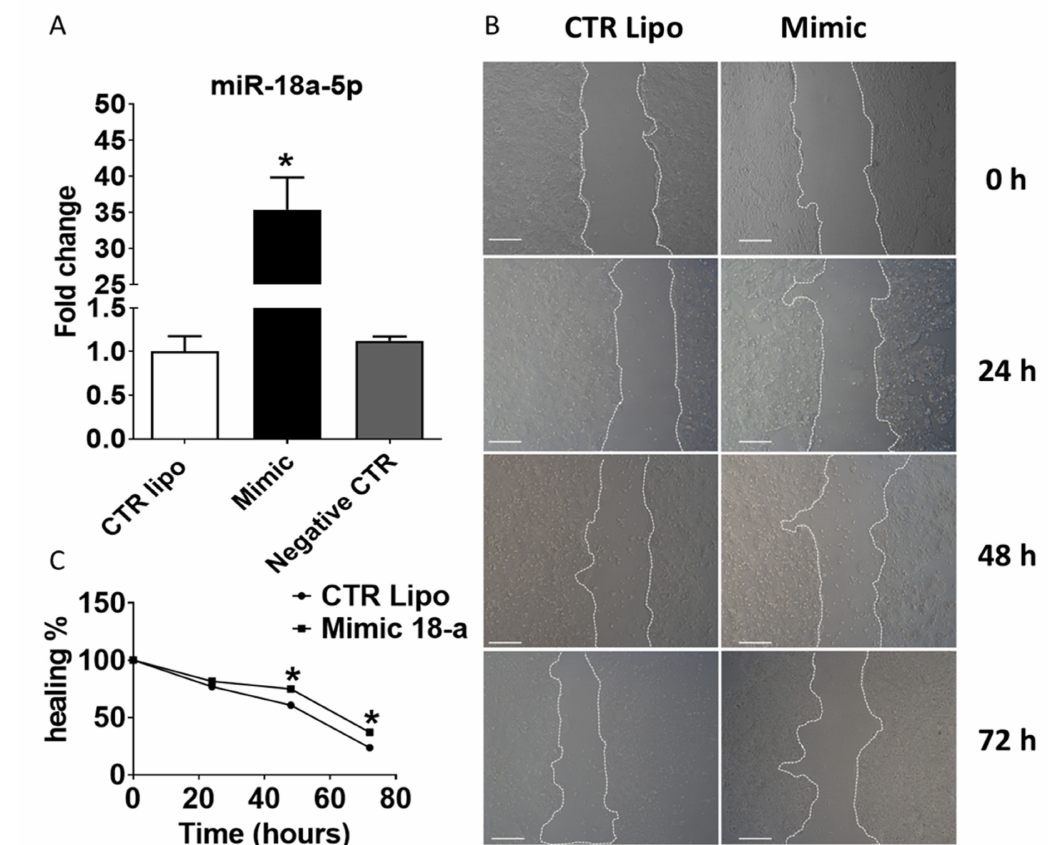
Figure 4. ( A ) Expression profile of miR-18a-5p in PNT-2 cells from the Control Lipo, Mimic, and Negative CTR groups after 24 h of treatment. ( B ). Representative wound healing assay images after 24, 48, and 72 h. ( C ). Cellular wound closure after the transfection of PNT-2 cells with lipofectamine and mimic miR-18a-5p after 0, 24, 48, and 72 h post-wound. Mimic group: cells treated with mimic miR- 18a-5p. In vitro studies were conducted in three independent experiments performed in triplicate. Data are expressed as mean ± SD. * means a statistical difference between experimental groups with p < 0.05. Scale bar: 200 µ m. CTR: